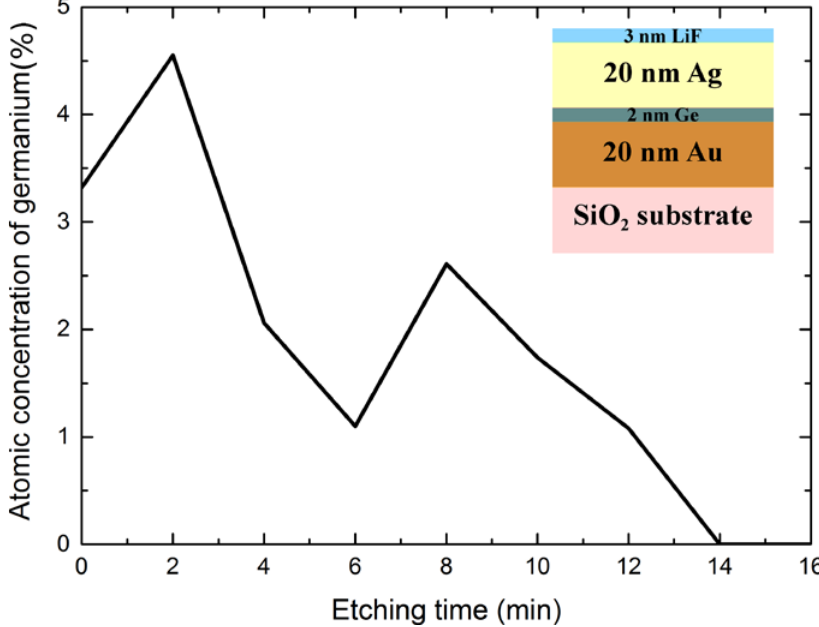
Figure 2. Atomic concentration profile of germanium atoms in the Au / Ge / Ag sandwich sample. Etching time is equivalent to subsurface depth. One minute of Ar + ion etching corresponds to removal of approximately 3 nm of the sample.